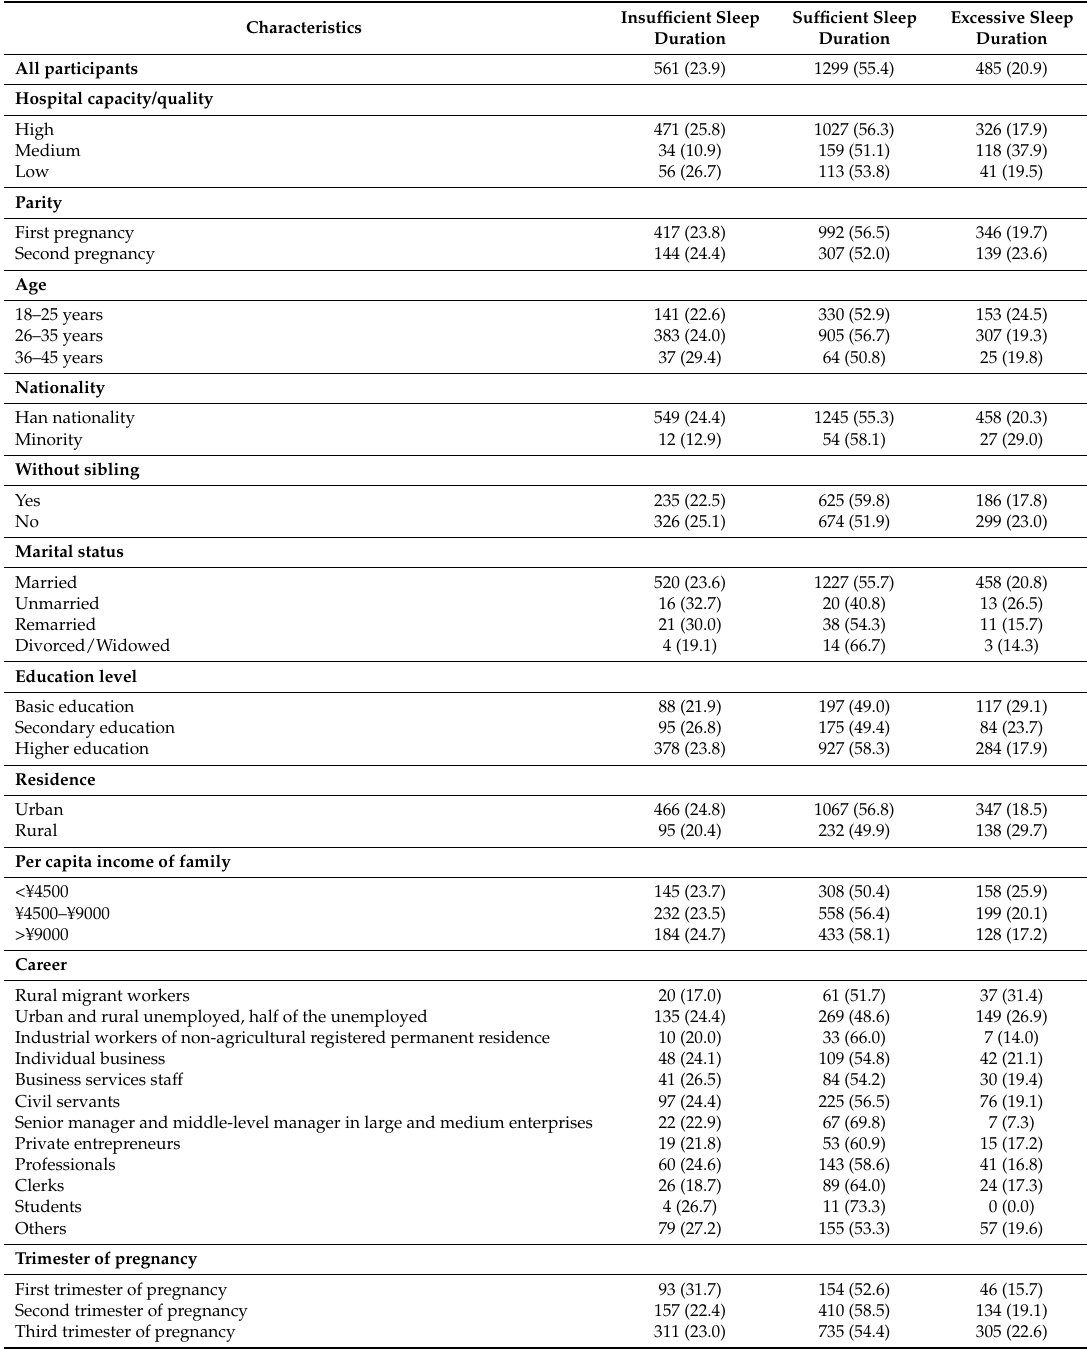
Table 1. Characteristics of study participants as stratified by sleep duration status in 2015 ( n , %).